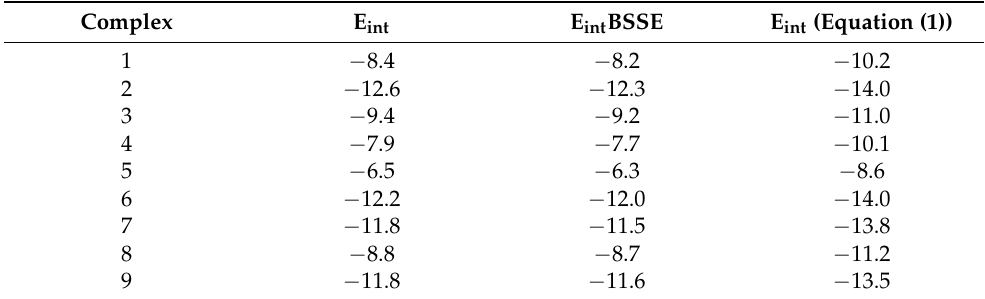
Table 5. Interaction energy (E int ) and this value corrected for basis set superposition error (BSSE) (E int BSSE); the interaction energy evaluated from the relationship of Espinosa is also included, E int (Equation (1)); values for complexes analyzed here in kcal/mol. The numeration of complexes follows Figure